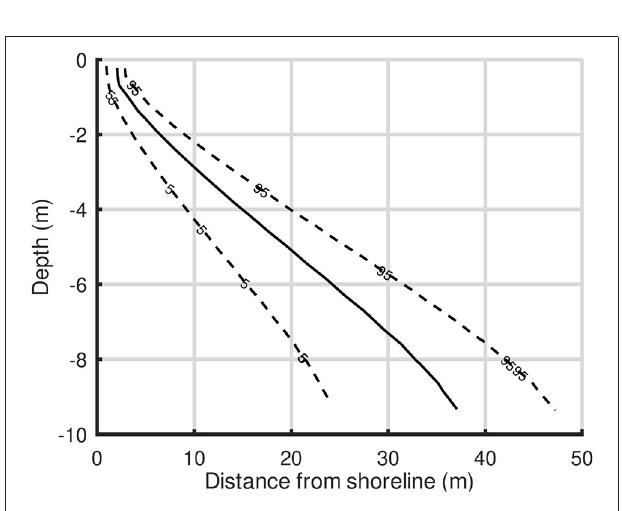
FIGURE 6 | Confidence interval (90%) of the 1,500 ppm TDS line for the aquifer with α =